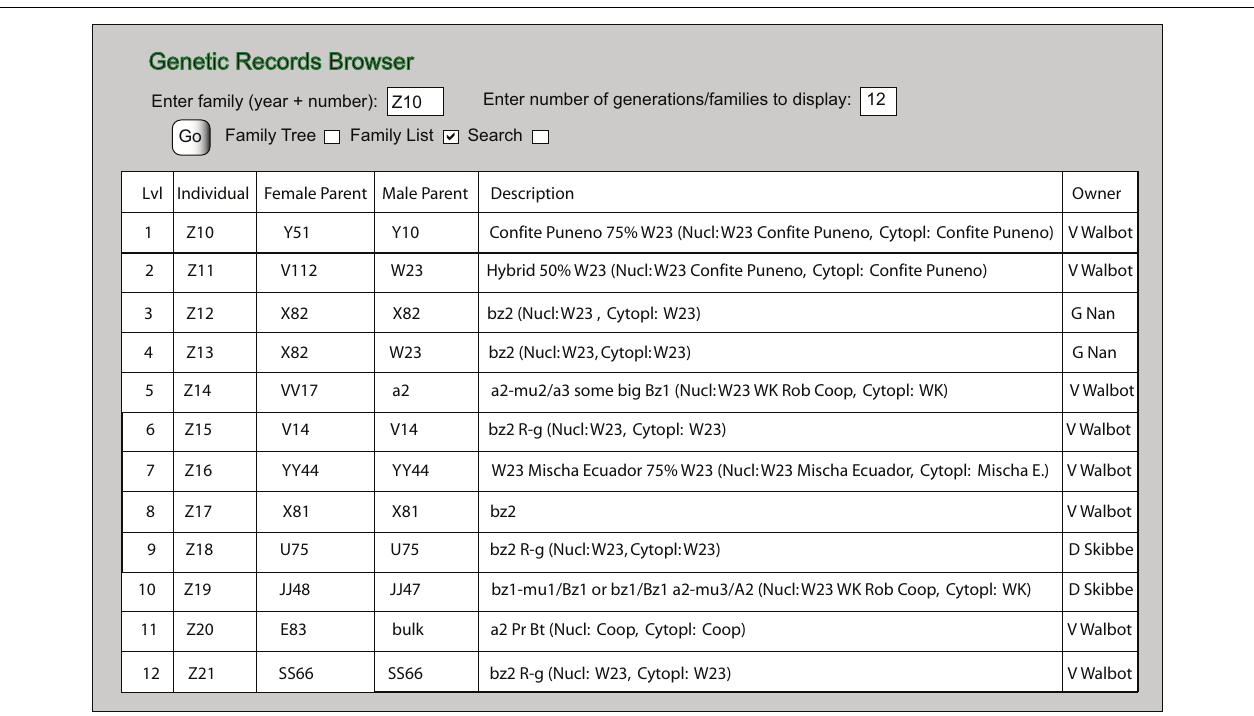
FIGURE 5 | Sequential list display. Table showing 12 individuals starting from individual Z10 and listed in the order they are found in the data file.Table columns are customizable.